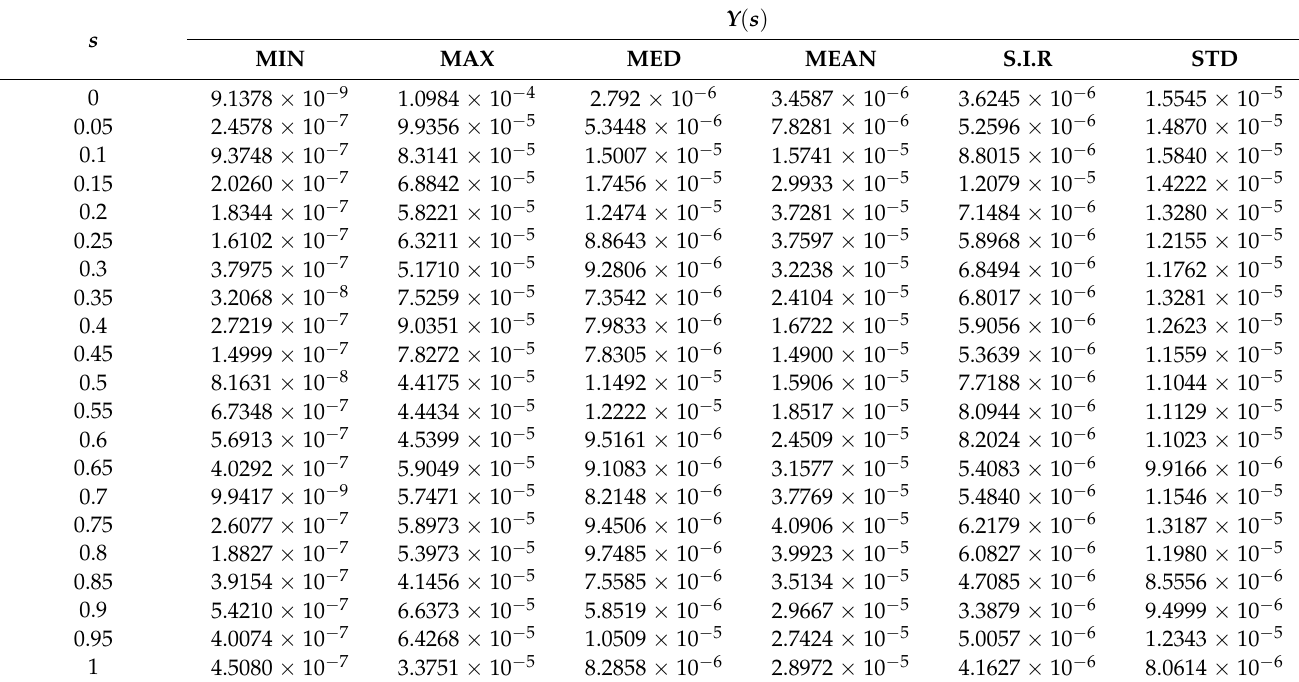
Table 3. Statistical presentations of the environmental and economic nonlinear model for Y ( s )